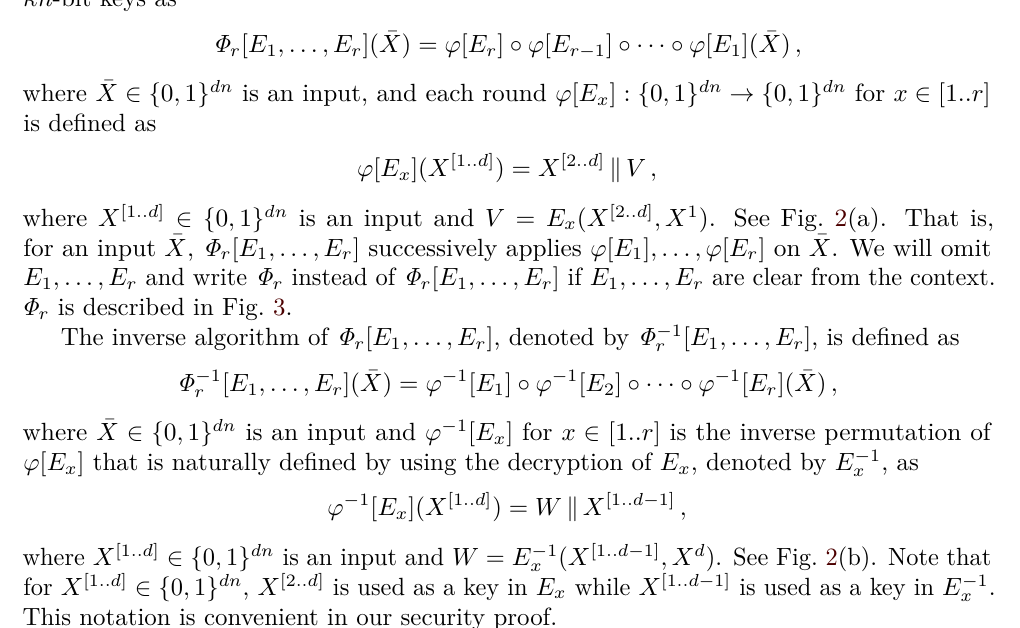
V and (b) ϕ − 1 [ E x ]( X [1 ..d ] ) = W k